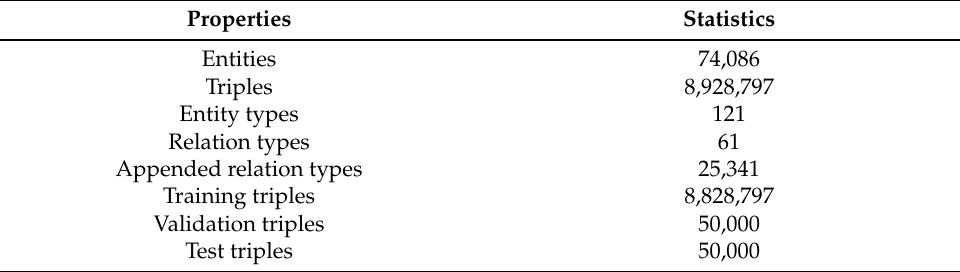
Table 1. Statistics of the SemNet-COVID training data.